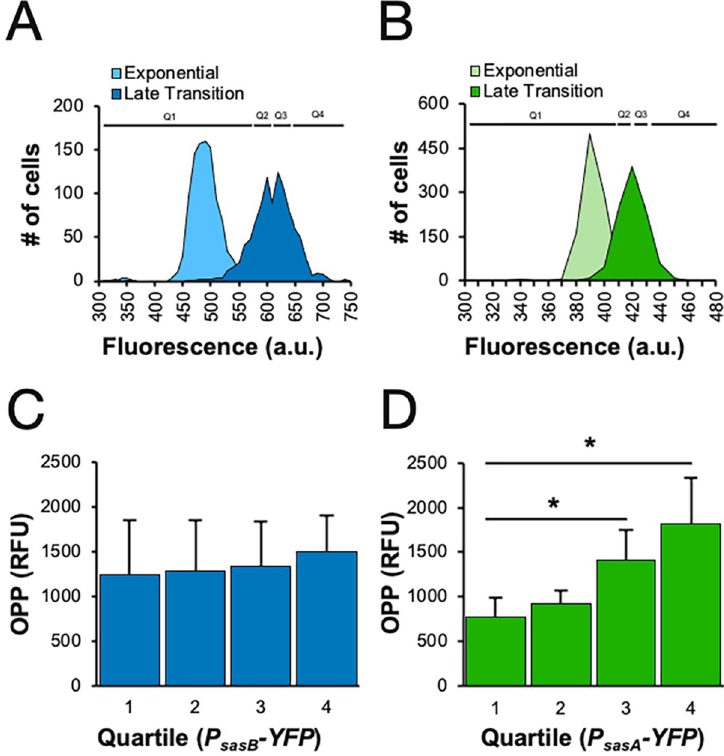
Fig 2. Relationship between sasA or sasB expression and OPP incorporation. (A, B) Representative population distribution of B . subtilis carrying a transcriptional reporter of (A) P sasB -yfp (JDB4341) or (B) P sasA -yfp (JDB4030) during exponential (light blue/green) and late transition phase (dark blue/green). Black lines represent quartiles used in C and D. (C, D) Average OPP incorporation in late transition phase of each quartile of (C) P sasB -yfp expression or (D) P expression from lowest to highest. Statistical analysis (one tailed t-test) showed no significant difference sasA -yfp in OPP incorporation between any P sasB -yfp quartiles (p > 0.05) and significantly higher OPP incorporation between quartiles 1 and 3 and quartiles 1 and 4 of P expression (p-values 0.027 and 0.016, respectively). sasA -yfp